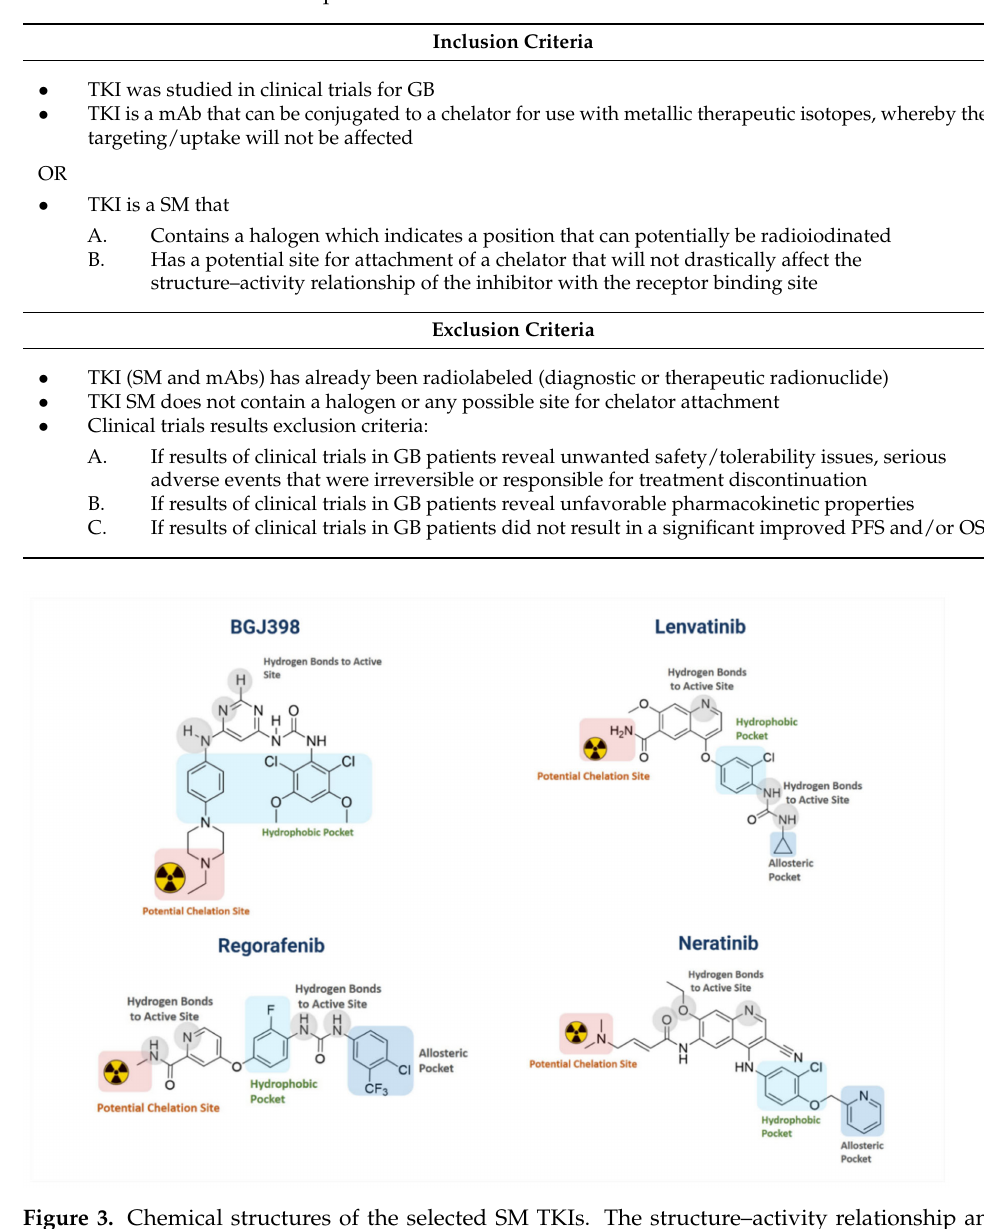
Figure 3. Chemical structures of the selected SM TKIs. The structure–activity relationship and potential radionuclide attachment sites are